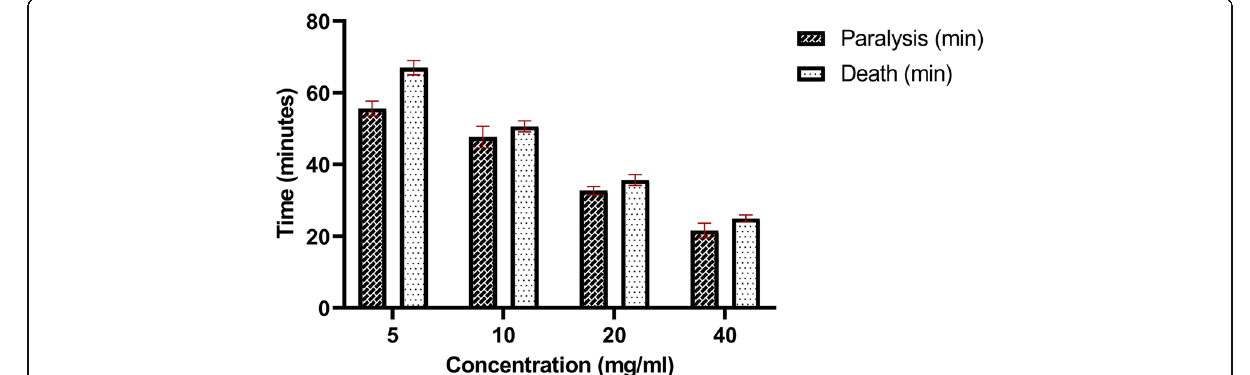
Fig. 7 Effect of CCLE upon death and paralysis of Pheretima posthuma